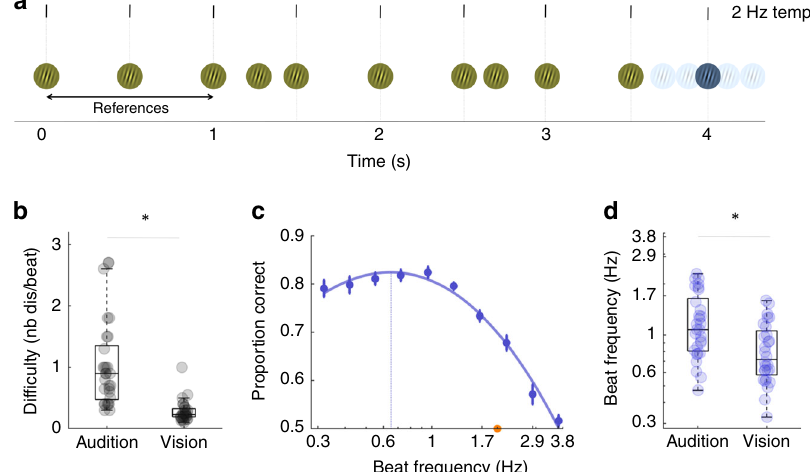
Fig. 3 Passive visual experiment: experimental design and results. Experiment 4. a In contrast to auditory experiment 1, sequences of visual gratings were presented on each trial. Participants performed a beat discrimination task by deciding whether the last grating of the sequence, a colour deviant (blue vs. yellow), was on or off beat. The beat frequency varied across conditions (from 0.3 Hz to 3.8 Hz) b Comparison of the individual dif fi culty levels obtained during the staircase procedures (with a 2 Hz tempo) of the auditory (exp. 1) and visual (exp. 4) experiments. c Average performance per condition. Same conventions as in Fig. 1c. d Comparison of individual estimates of the optimal tempo, between auditory (exp. 1) and visual (exp. 4) experiments. Error bars indicate s.e.m. ( n = 30; unpaired t -tests; * p < 0.05). Boxplots represent median and 1.5 times the interquartile